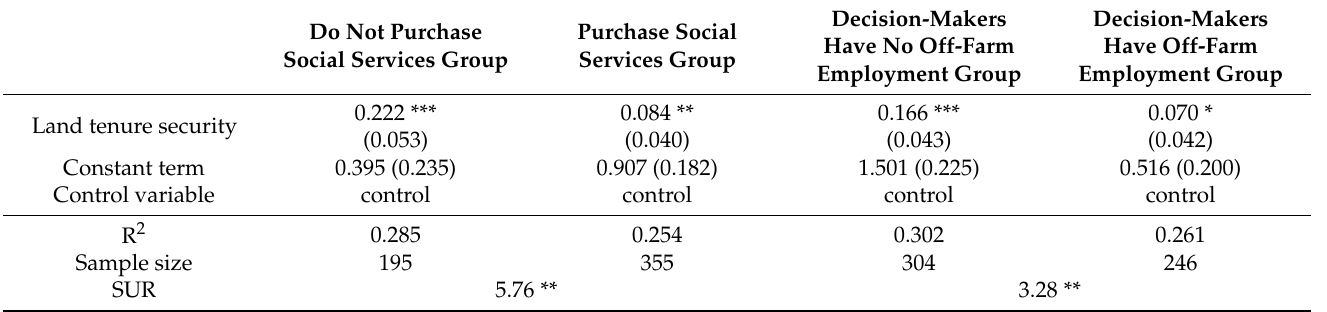
Table 5. Heterogeneity analysis of land tenure security on cultivated land